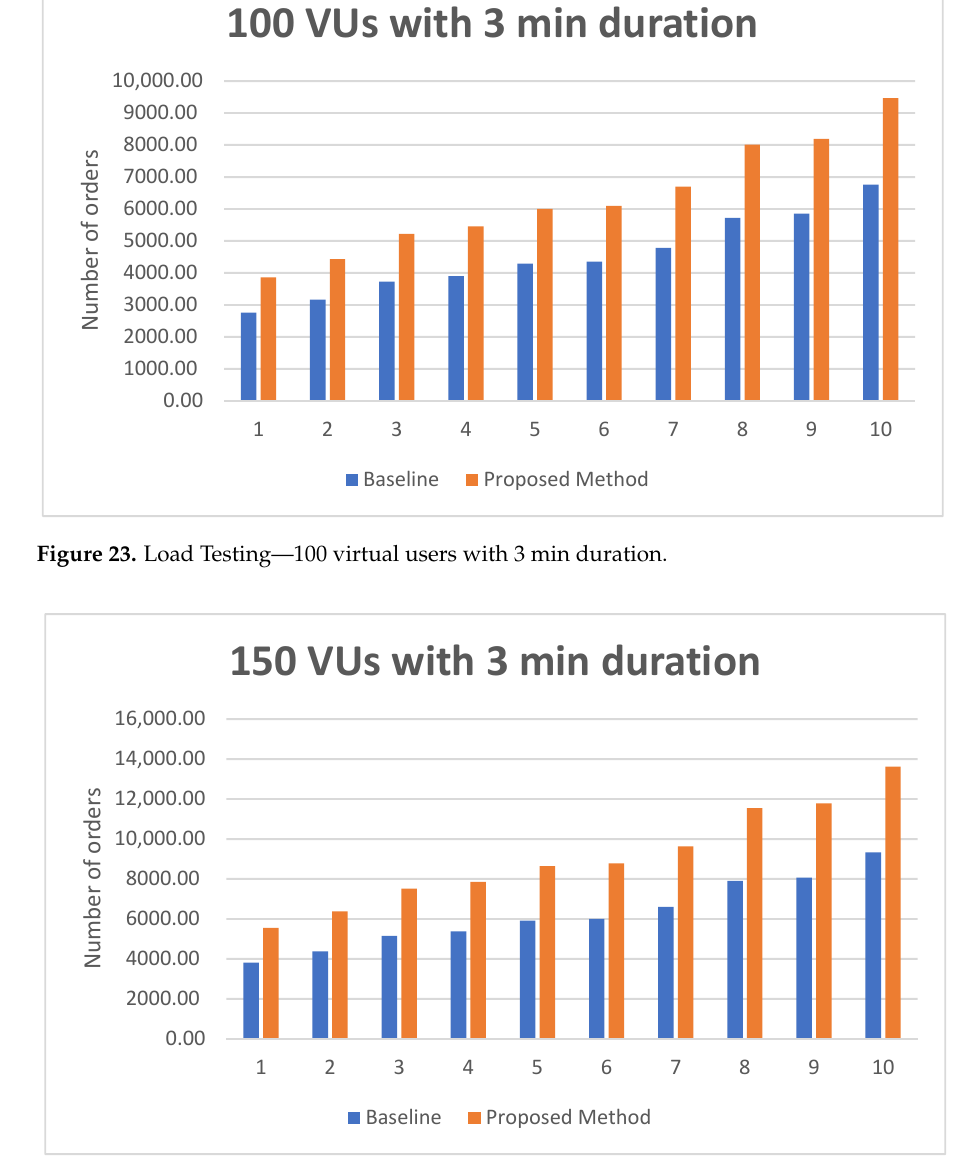
Figure 24. Load Testing—150 virtual users with 3 min duration.